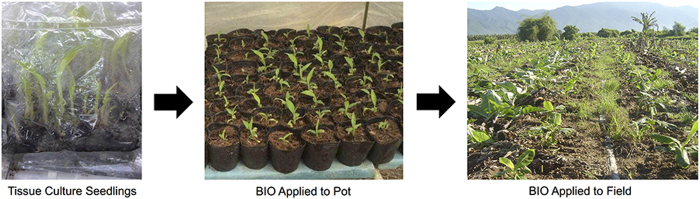
Roadmap of nursery pot application of bioorganic fertilizer (BIO).Picture taken by first author Chao Xue.